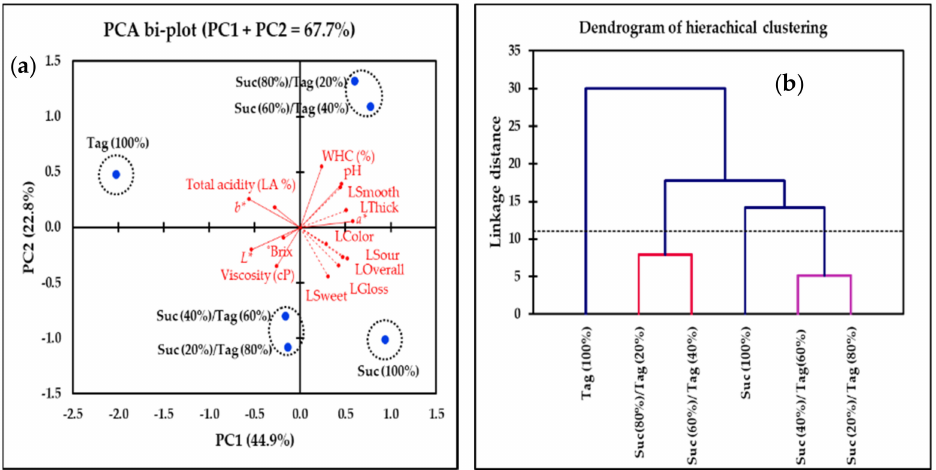
Figure 4. ( a ) Principal component analysis (PCA) bi-plot and ( b ) cluster analysis visualizing treatments (strawberry-flavored yogurt samples), liking attributes (dash line vectors; smoothness, thickness, color, sourness, glossiness, sweetness, and overall liking), and physico-chemical properties (solid line vectors; pH, total acidity, viscosity, water holding capacity, color, and ◦ Brix) at day 1 of storage time (treatment labels are shown in Table